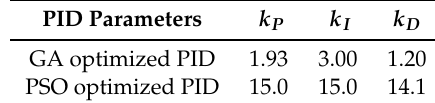
Table 2. Optimized PID controller